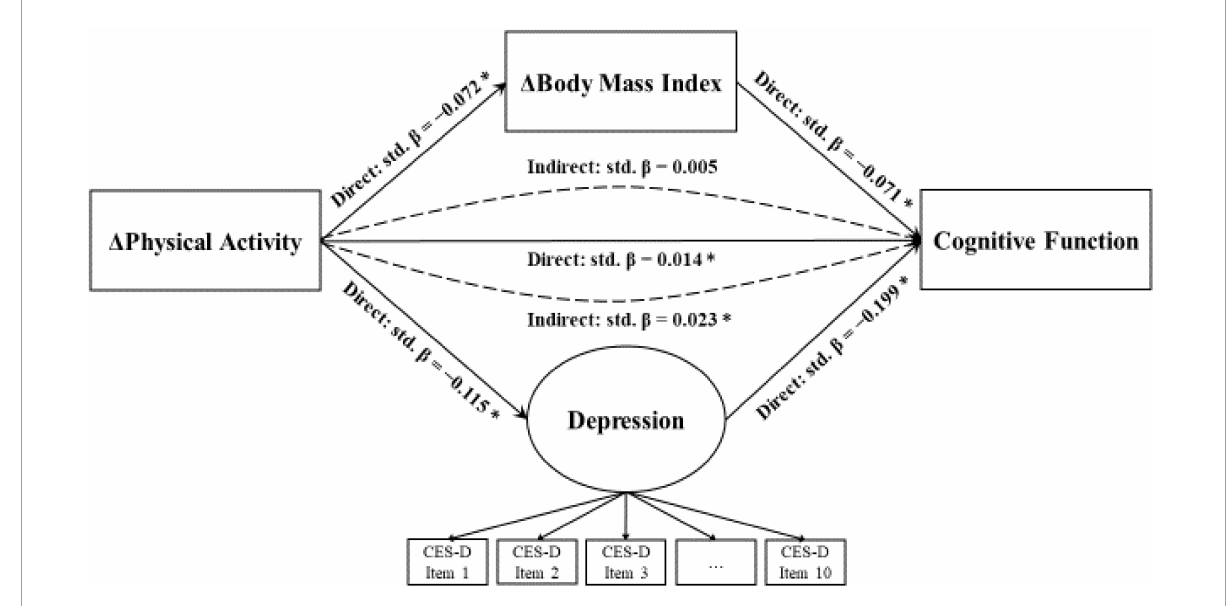
FIGURE3 Standardized solution of the structural mediation model. * p -value <